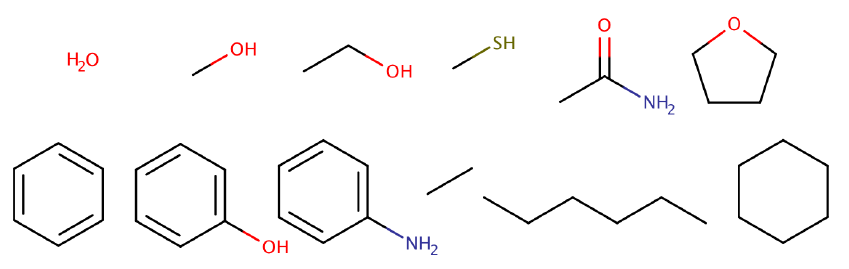
Figure 1. Twelve simple molecules were employed for the determination of hydration free